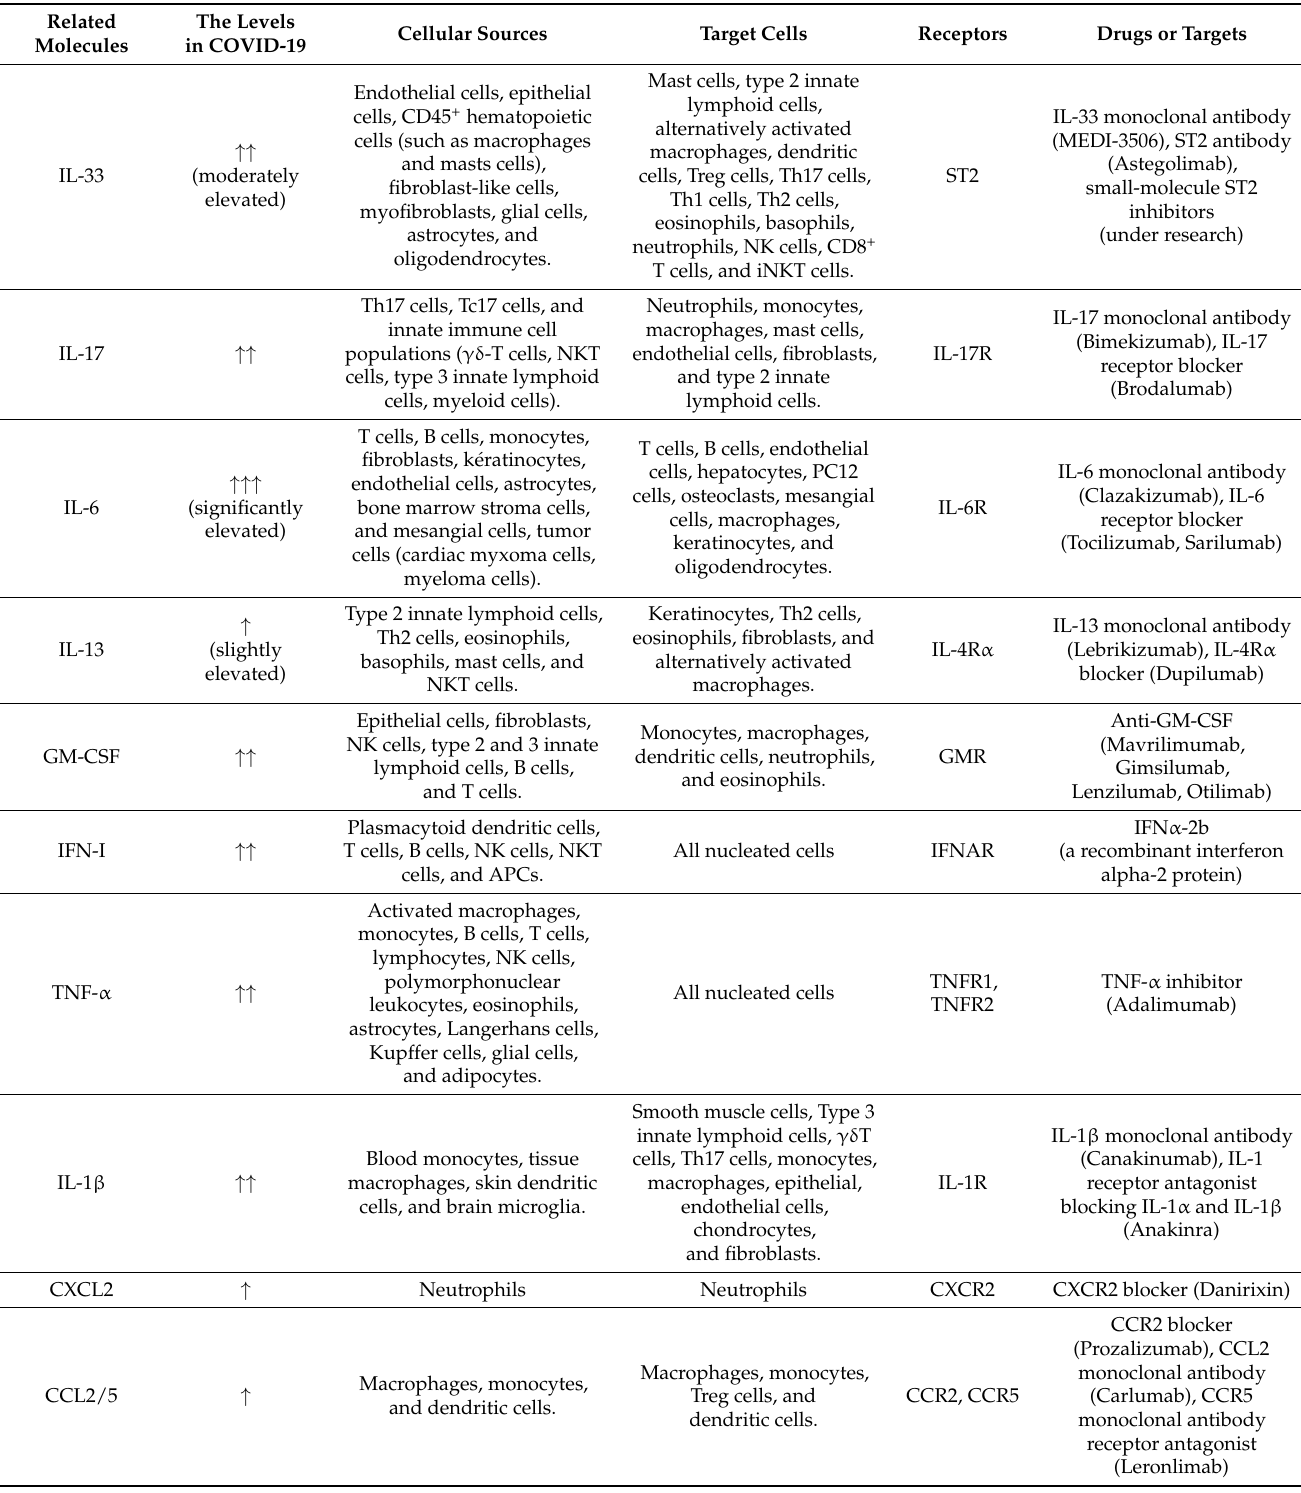
Table 1. Molecules involved in the cytokine storm of